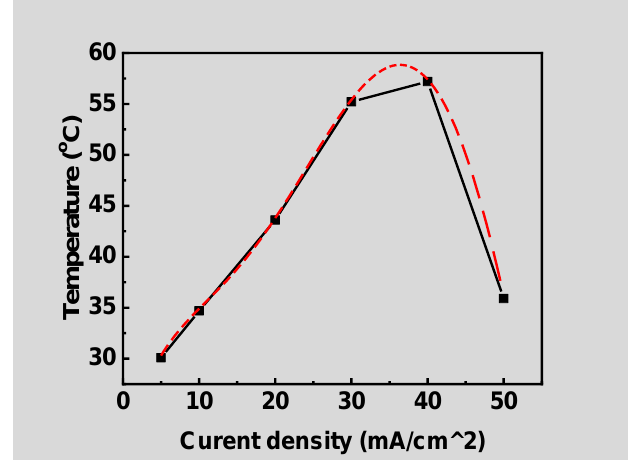
Figure 11. The variation of the OLED surface temperature with driving current.